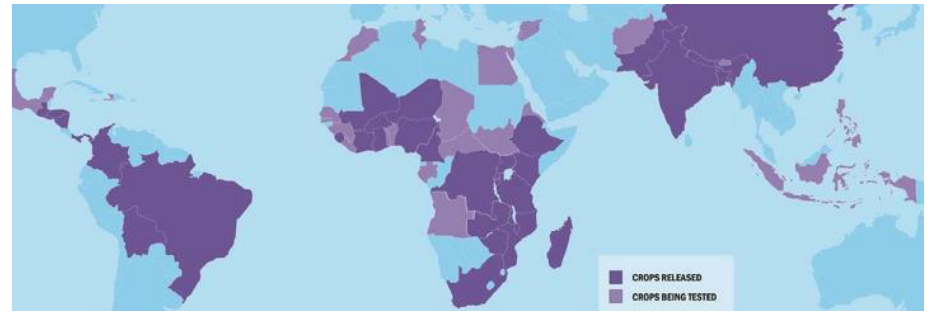
Figure 2. In purple, crops currently released commercially. In lilac, crops being tested [70].